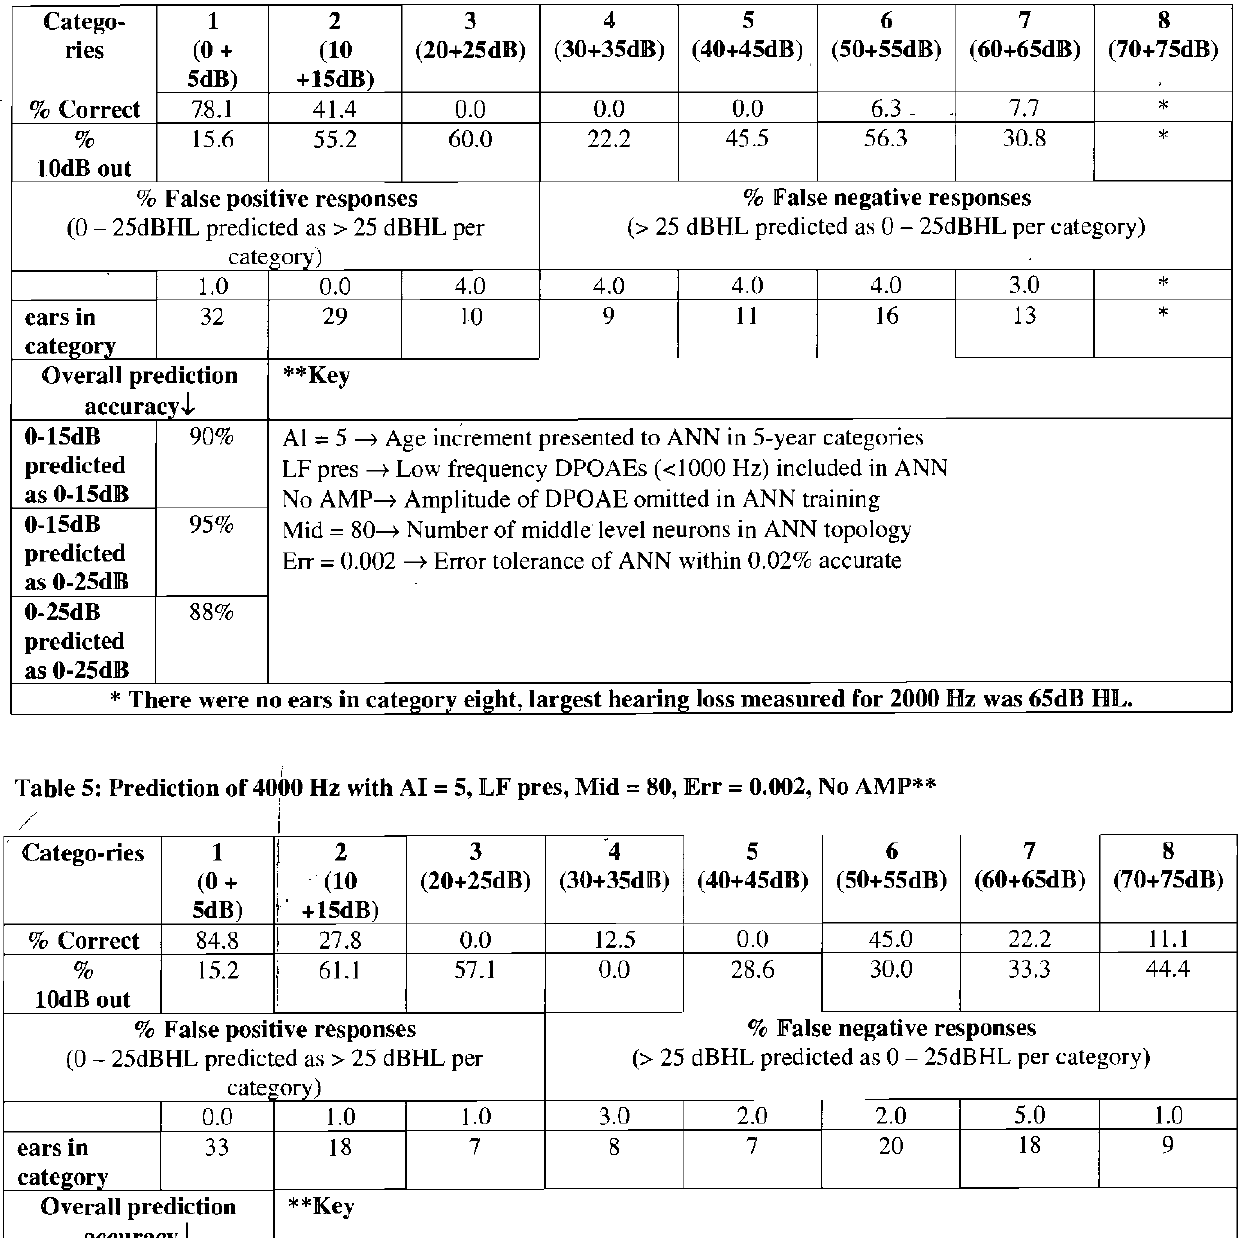
Table 4: Prediction of 2000 Hz with Al = 5,LF pres, Mid = 80, Err = 0.002, No AMP ** Catego-